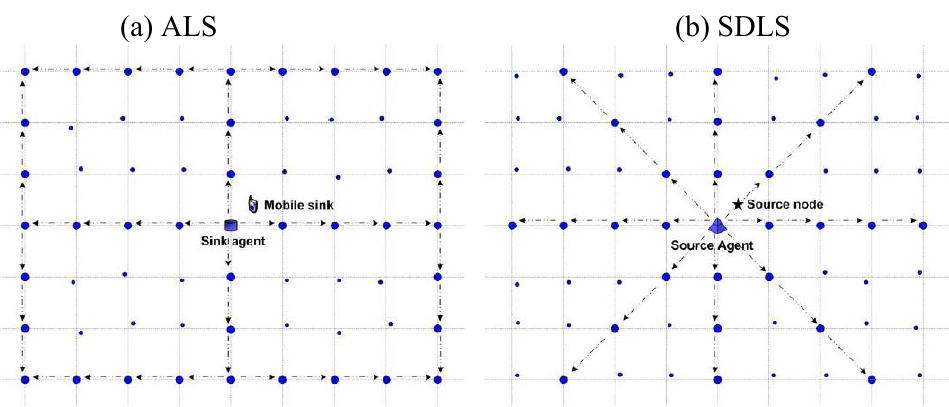
Figure 2. Selection of location service